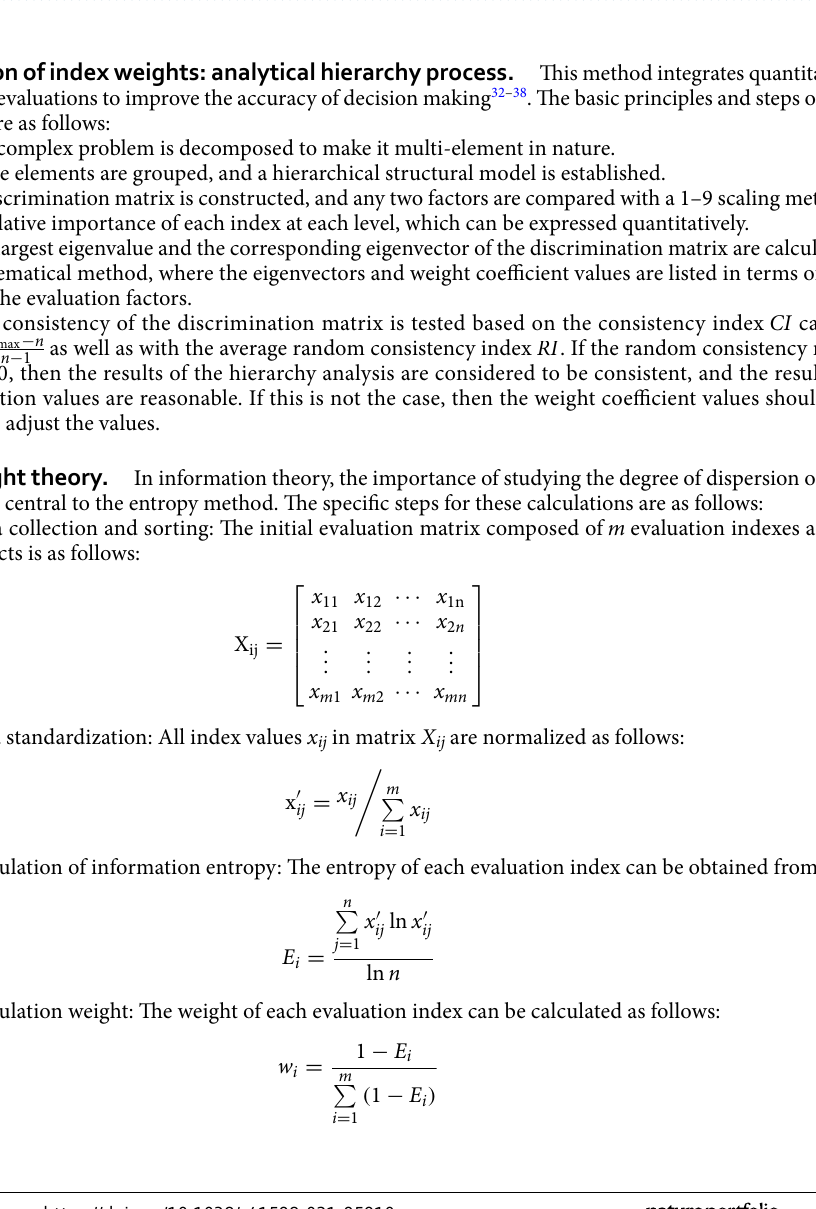
Table 3. Correlation function value of each evaluation index used in an evaluation of overseas mining investment in the